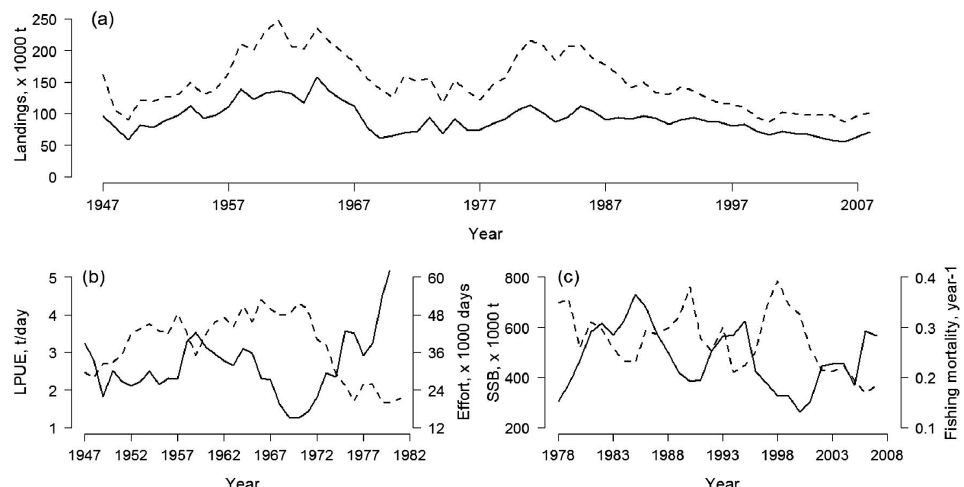
Fig . 1. – (a) Historical series of Portuguese (solid line) and total stock (dashed line) landings of sardine 1947-2008 (b) LPUE (solid line) and fishing effort (dashed line) for the Portuguese purse seine fishery in 1947-1981; (c) spawning biomass, SSB (solid line), and fishing mortality, F (dashed line) for the Atlanto-Iberian stock in 1978-2008. Plot (b) constructed from data in Mendes and Borges (2006), plots (a) and (c) constructed from stock assessment in ICES (2010).